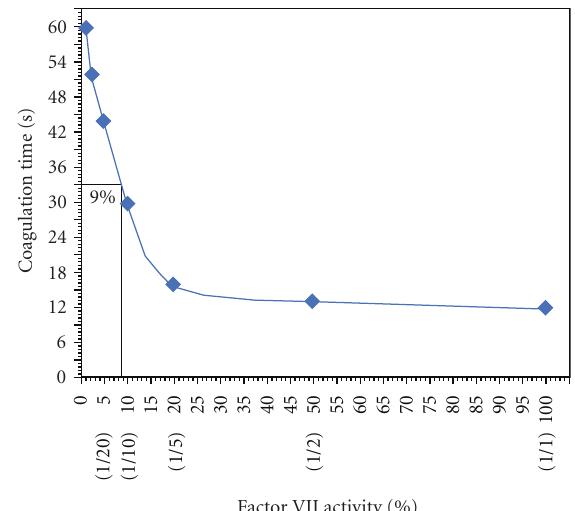
Figure 7: Estimation of the yield of functional rFVII (rFVIIa) by one-stage clotting assay (PT-based assay for FVII). Standard curve of di ff erent dilutions of unicalibrator was made. Also, clotting times of dilutions of (1/1), (1/2), (1/5), (1/10) of dialyzed rFVII were recorded. The clotting times of dilutions of dialyzed rFVII were 33, 42, 44, and 48 (s), respectively. The black line mark the (1/1) dilution of dialyzed rFVII activity at the point of intersection of the standard curve through this the yield of functional rFVII (rFVIIa) was estimated 9% of Unicalibrator with 100% FVIIa level. The clotting time of the negative control sample (without FVII) was 60